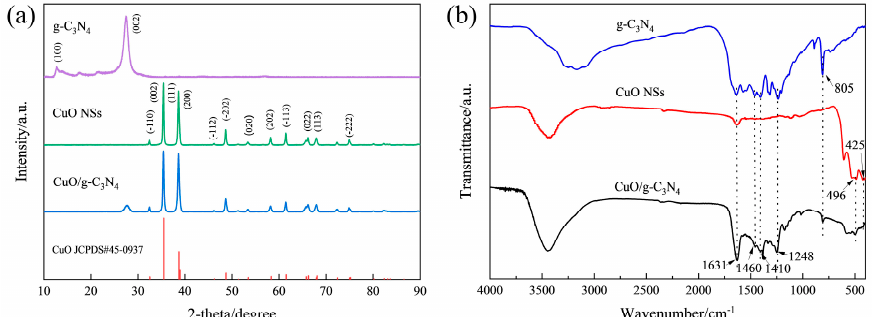
Figure 4. ( a ) XRD patterns of g-C 3 N 4 , CuO NSs and CuO/g-C 3 N 4 , ( b ) FTIR spectra of g-C 3 N 4 , CuO NSs and CuO/g-C 3 N 4 .